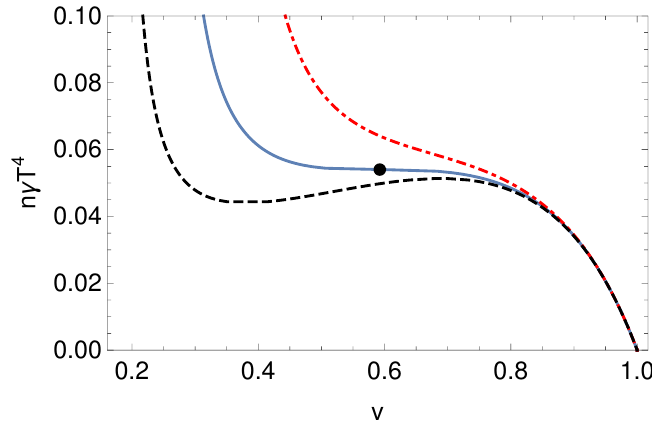
Figure 15 . The relation between (cid:13) T 4 and v = a=b (for n 1 = n 2 ) at the critical value r = r c (full line) with the critical point indicated by a black dot on top of it. The dotted and dashed lines correspond to a crossover situation with r = 1 : 1 r c and a (cid:12)rst-order phase transition with r = 0 : 95 r c ,